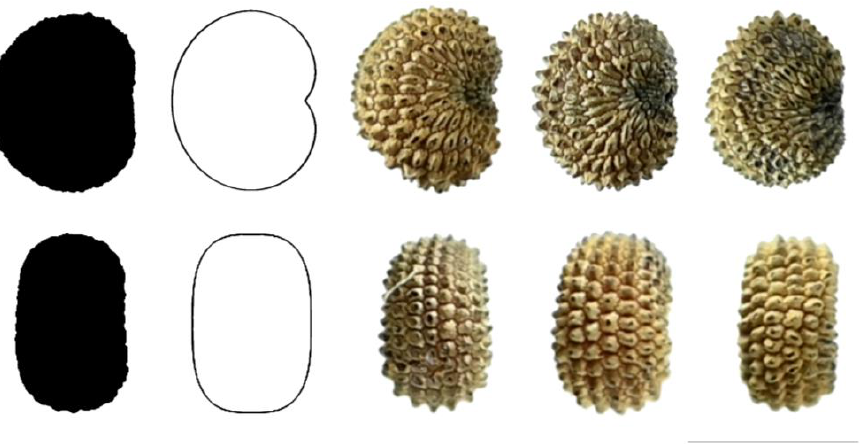
9 Figure 7. Silene aprica : average silhouettes (left), the models giving best scores with 20 seeds (LM2 and DM10), and three representative images for the lateral (above) and dorsal (below) seed views. Bar represents 1 mm. Twelve species gave the best scores in the model LM4, but the dorsal models were different for some of them (Table 1). The seeds of four species adjusted well to convex models DM1 to DM3. The seeds of S. jeniseensis adjusted to LM4 and DM1 (Figure 8), those